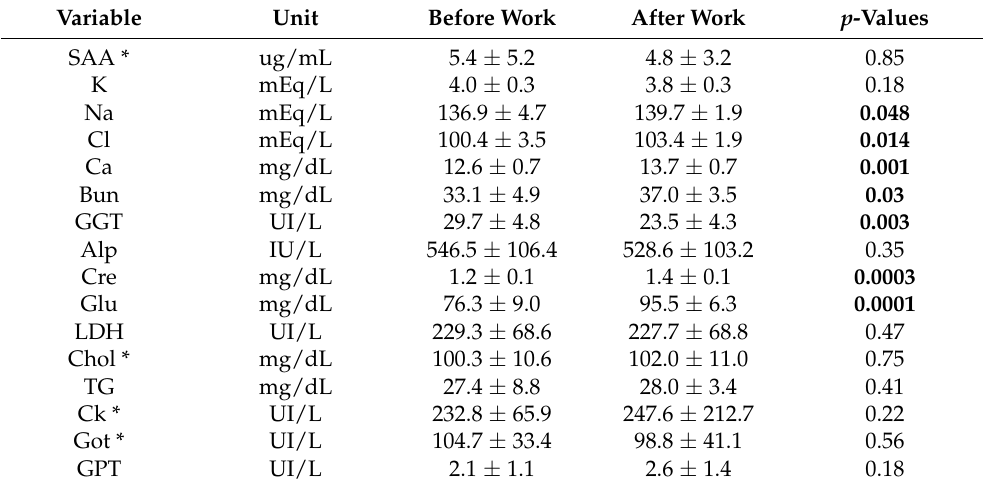
Table 1. Mean values ± standard deviations (SD) of studied variables in mules before and after work. p -values obtained by paired t -test and Mann–Whitney test (*), respectively, are indicated in bold when statistically